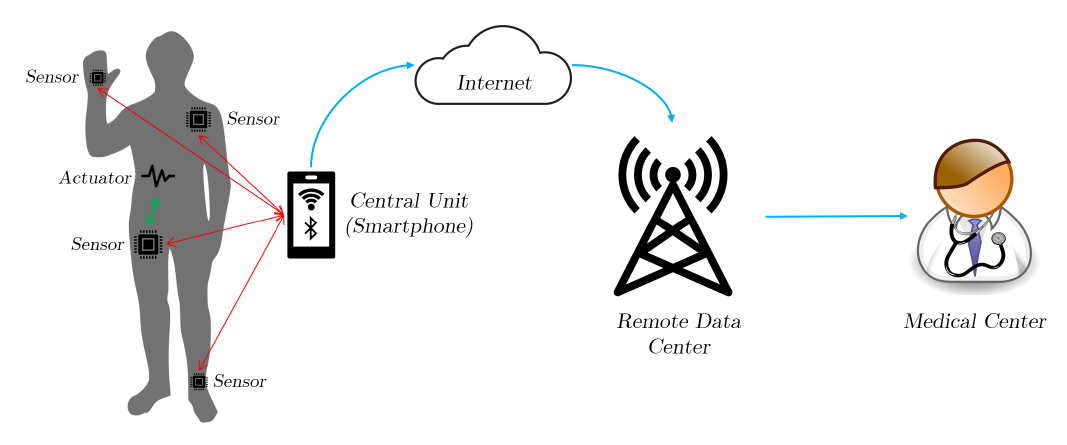
Figure 1. An example Wireless Body Area Network (WBAN)